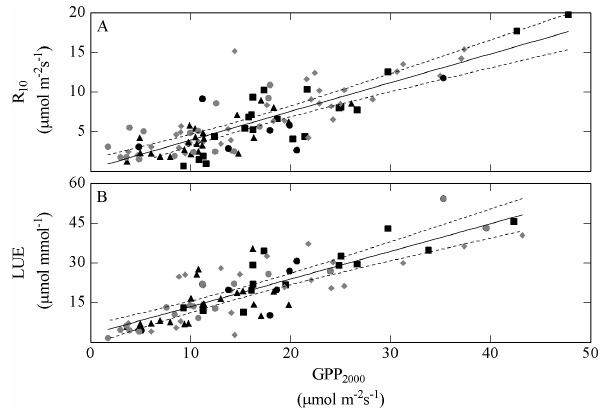
Fig. 8. ( A ) Maximum gross primary productivity (GPP max ) (grey bars) and maximum ecosystem respiration (R max ) (black bars), ( B ) ratio of R max and GPP max for different ecosystems across the globe. Ecosystems are indicated as: M (meadows), P (pastures), A (aban- doned), N (natural grasslands, including steppes and prairies, tun- dras and savannas). Significantly different means are indicated by different letters (oneway ANOVA). Error bars represent standard er- rors, meadows n=28 (References: Barcza et al., 2003; Byrne et al., moun- 2005; Falge et al., 2002; Gilmanov et al., 2007; Lawton et al.,